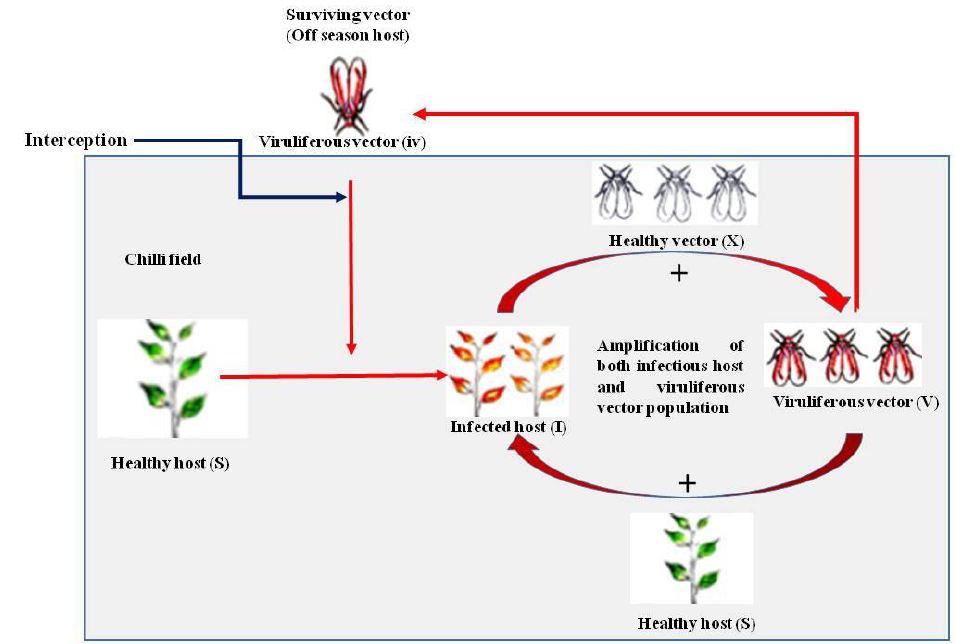
Figure 4. Workable positive feedback loop for the infectious host ( I ) and viruliferous vector ( V ) population incited by the migrant vectors.